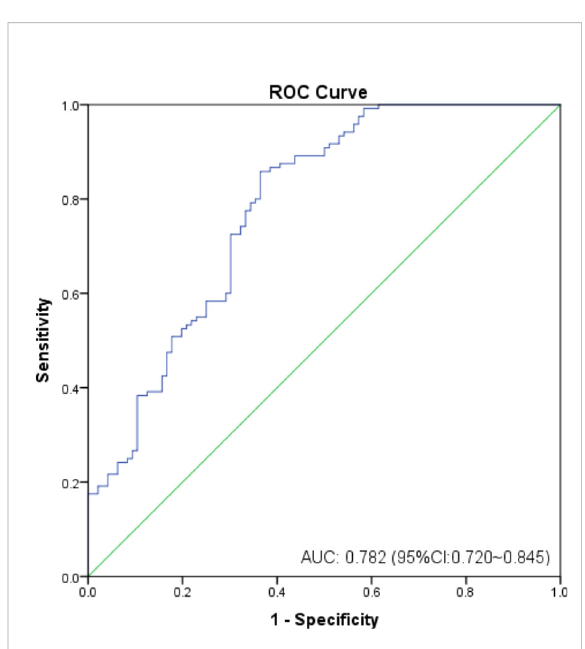
FIGURE 3 ROC analysis of sHLA-G between cervical cancer patients and healthy women